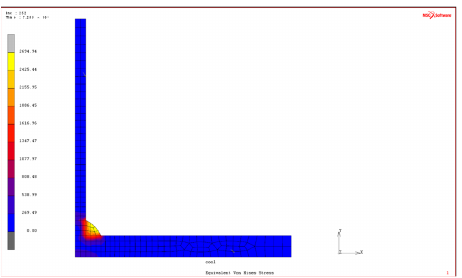
Figure 17. Distribution of equivalent von Mises stress for Al 6061 T6.